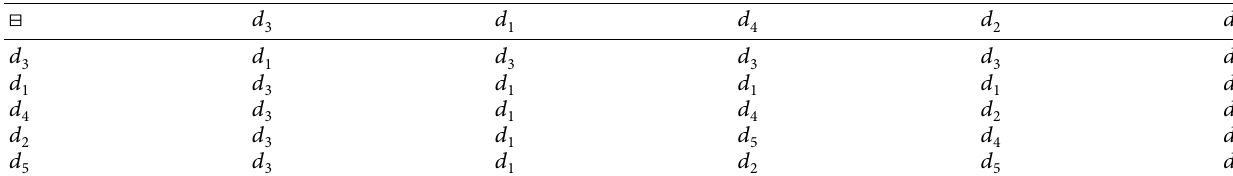
Table 12: Composition of B under the rule ⊟ .